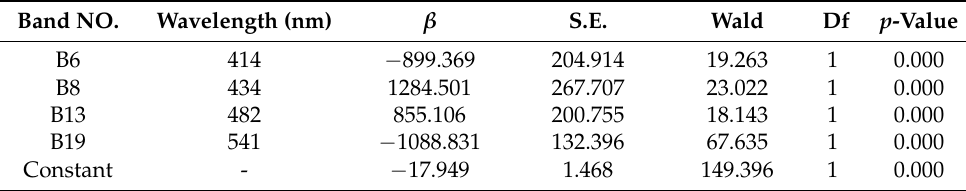
Table 4. CAP logistic model parameters derived from BLR and Wald test.